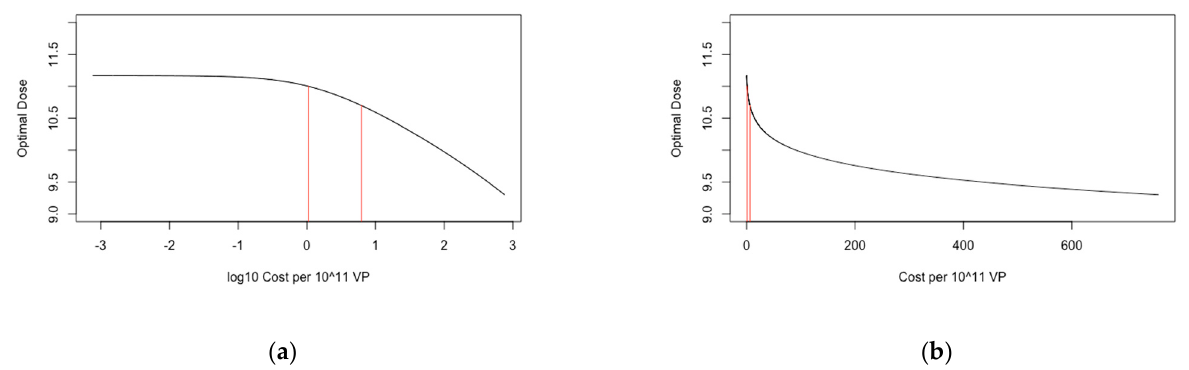
Figure 5. Optimal predicted dose (log10 scale) for +/ − 3 orders of magnitude (log10 scale) around Cost per 10 11 viral particles . Table 1. viral particles at a log10 scale and the right is scaled normally. The black line represents the optimal dose, and the red lines indicate the threshold values of Cost per 10 11 viral particles for which the optimal dose was 1 × 10 11 and 5 × 10 10 VP.